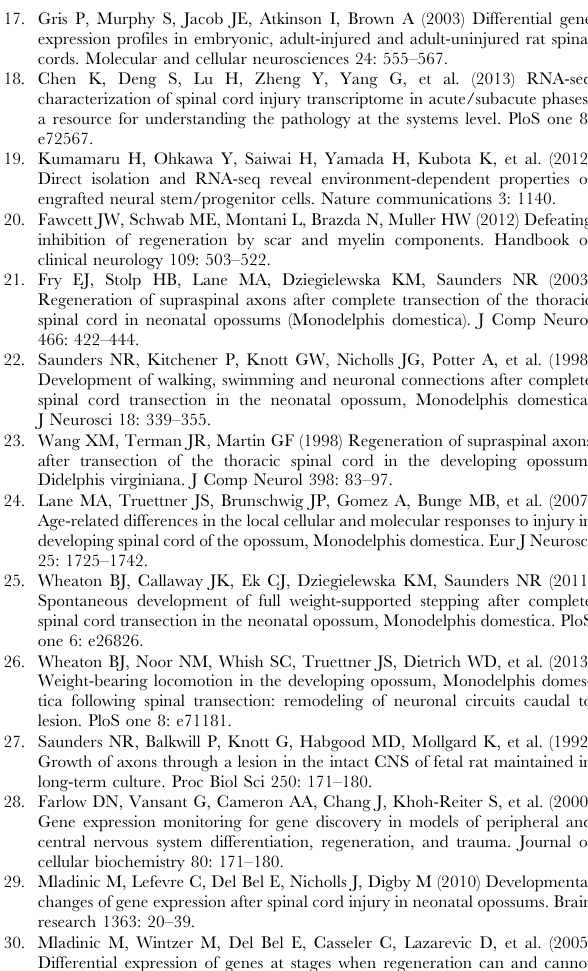
Table S6 Proteomic results of identified proteins in different fractions and bands compared with expression of their respective genes in the transcriptome. Column A shows fraction in which protein was identified, Column B shows band in gel in which protein was identified. Note that some proteins were identified in more than one fraction or band. Column C is ENSEMBL protein ID, where known. Column D is protein name. Column E and F show whether protein band density was increased $ 0.5 compared to age-matched controls 24 h following spinal cord injury at P7 or P28. Column G shows corresponding gene symbol or name. Column H shows ENSEMBL gene ID. Column I and J show gene expression level 24 h following injury at P7 or P28. Note the relative lack of correlation between identified changes in the transcriptome and the proteome. Updated 13 May 2014 Table S7 A. Proteins that were identified as changing expression level in the spinal cord rostral but not caudal to the site of transection 24 h after injury at P7. increased band density, decreased band density. Some proteins showed an increase or decrease in different fractions ( ). B.